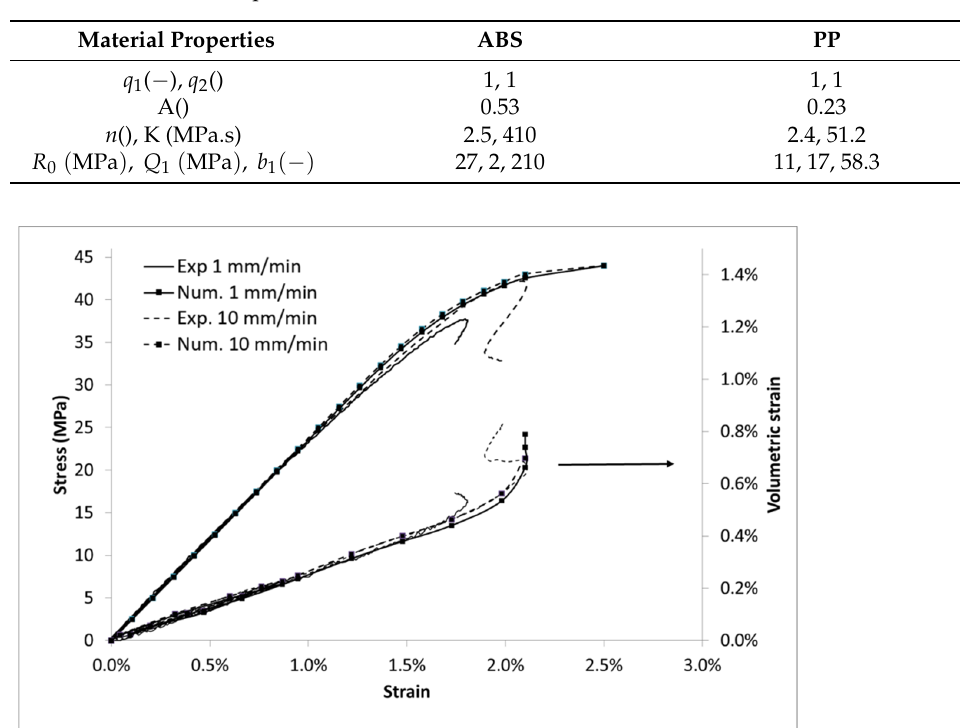
Figure 14. Modelling of ABS, stress and volumetric strain vs. Lagrangian strain.